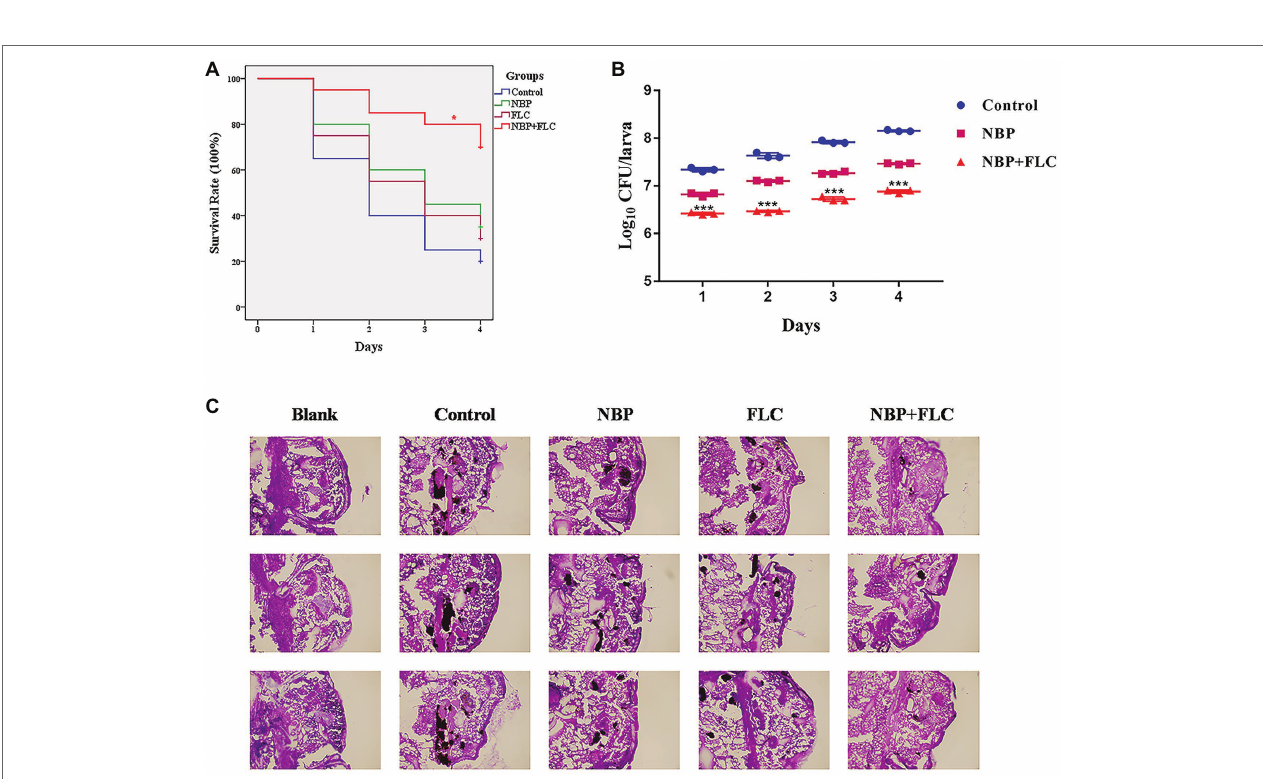
FIGURE 3 | Effect of NBP in combination with FLC during G. mellonella infection with C. albicans. Larvae were injected with the inoculum of a cell concentration of 10 6 CFU/larva and then treated with PBS (control), FLC (160 μg/ml), NBP (40 μg/ml), or FLC (160 μg/ml) combined with NBP (40 μg/ml). (A) Survival curve of G. mellonella i nfected with C. albicans . Values represent the means ± standard deviation of three replicates. * p < 0.05 compared with the NBP-treated group (Kaplan-Meier test). (B) Fungal burdern of G. mellonella infected with C. albicans . Data for the treatment of FLC monotherapy group were not showed because the data were similar with that of the NBP group. Values represent the means ± standard deviation of three replicates. *** p < 0.001 compared with the NBP-treated group (unpaired t -test). (C) Histopathology of G. mellonella infected with C. albicans . Larvae of the blank group were treated with neither C. albicans nor drugs. Melanized nodules containing yeast clusters and filaments could be observed except in blank group. The photographs were collected from three independent